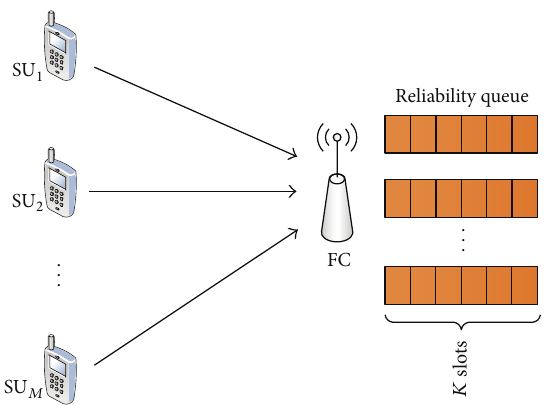
Figure 2: Reliability queue at the fusion